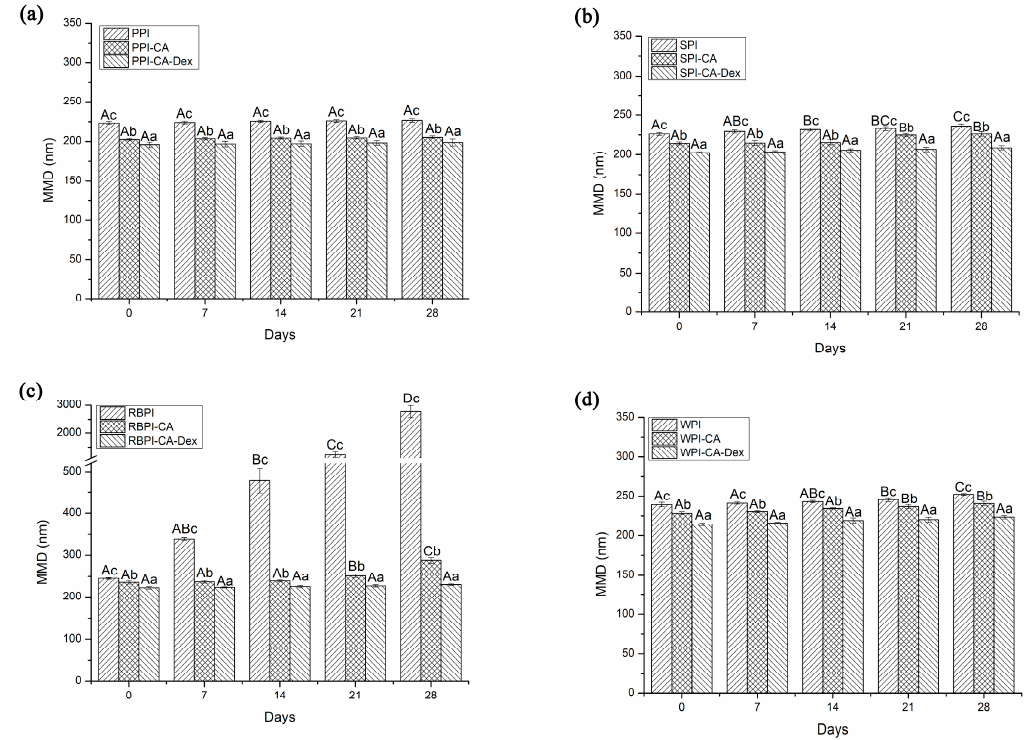
Figure 6. The MDD of nanoemulsions stabilized by NP, PC, and PCD samples under different storage weeks. ( a ) represented the MDD of nanoemulsions stabilized by PPI, PPI-CA and PPI-CA-Dex under different storage weeks; ( b ) represented the MDD of nanoemulsions stabilized by SPI, SPI-CA and SPI-CA-Dex under different storage weeks; ( c ) represented the MDD of nanoemulsions stabilized by RBPI, RBPI-CA and RBPI-CA-Dex under different storage weeks; ( d ) represented the MDD of nanoemulsions stabilized by WPI, WPI-CA and WPI-CA-Dex under different storage weeks. A–D represented that there were statistically differences ( p < 0.05) in MDD in different storage time of same samples, a–c represented that there were statistically differences ( p < 0.05) in MDD in same storage time of different samples.